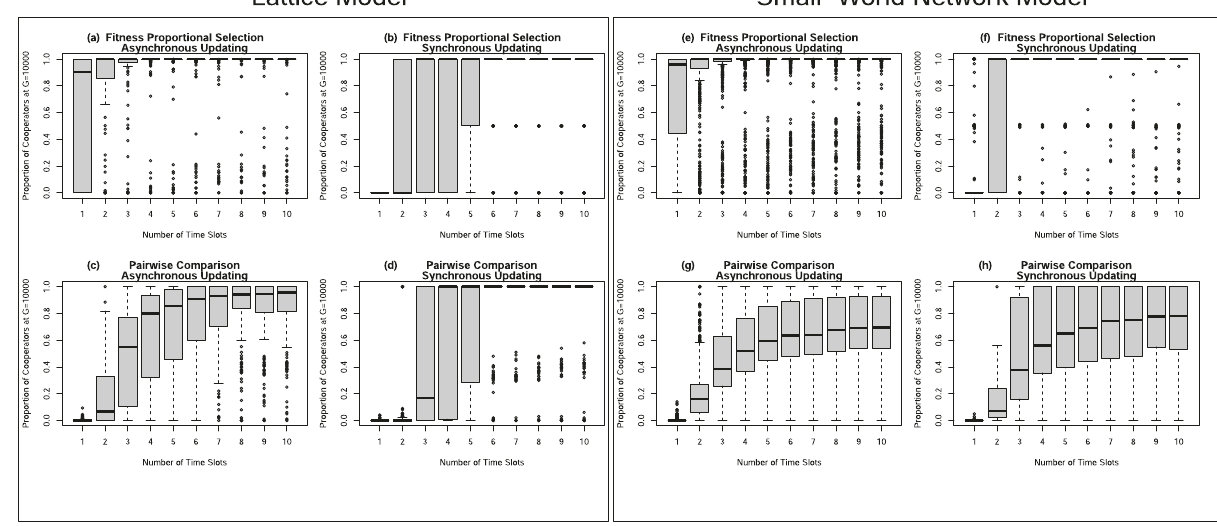
Fig. 6 Varying the number of time slots in fl uences the evolution of cooperation under combinations of transition rules and update dynamics. Panels present box plots that display information about the distribution of cooperators ’ fi nal population share across simulation runs, when data are separated by the number of time slots in those runs. a – d Present data from models in which agents interacted on a lattice, while e – h present data from models in which agents interacted in a small-world network. The index presented in Table 1, as well as the main heading of each panel, distinguishes the combination of transition rule and update dynamics used in simulations generating the data for a given panel. Heavy black lines denote the median value of the proportion of cooperators at G = 10000. The upper edge of a gray rectangle denotes the 75th percentile of the proportion of cooperators at G = 10000 and the lower edge of a gray rectangle denotes the 25th percentile, such that the full gray rectangle denotes the inter-quartile range (IQR). Points represent values that reside either a distance more than 1.5 times the length of the IQR above the 75th percentile or a distance more than 1.5 times the absolute length of the IQR below the 25th percentile. The short horizontal lines perpendicular to vertical dashed lines denote either the maximal value that rests less than 1.5 times the span of the IQR above the 75th percentile or the minimal value residing no further than 1.5 times the span of the IQR below the 25th asynchronous under pairwise selection, 20.5% of runs resulted in cooperator fi xation versus 15.7% of runs resulting in defector fi xation. When updating was synchronous under pairwise